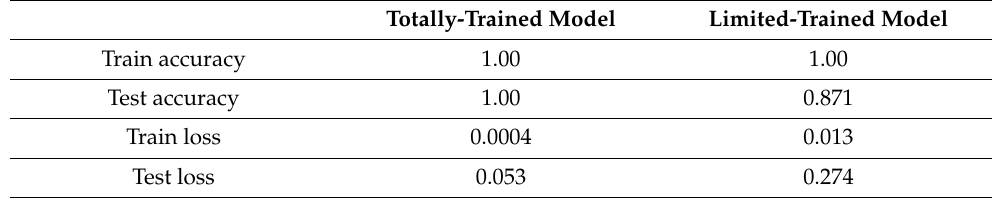
Table 4. Comparing the performance of fine-tuning